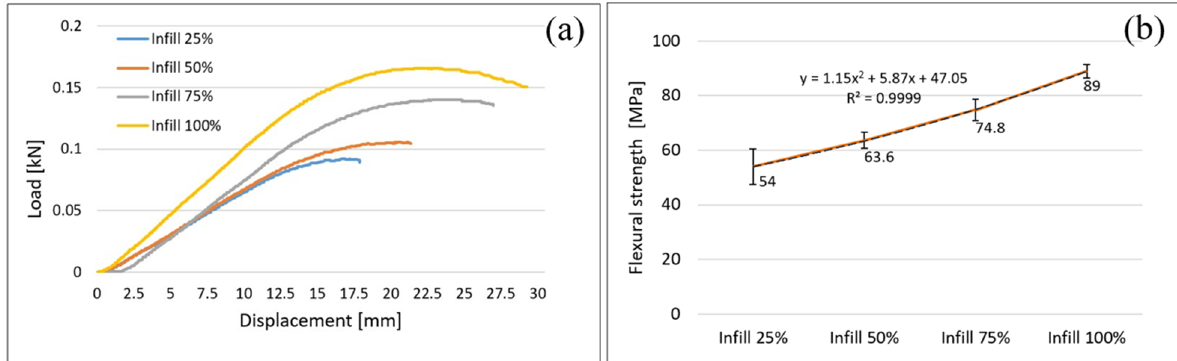
Figure 3. Tensile properties of 3D FFF samples. ( a ) load-displacement curves; ( b ) relationship between tensile strength and infill density.